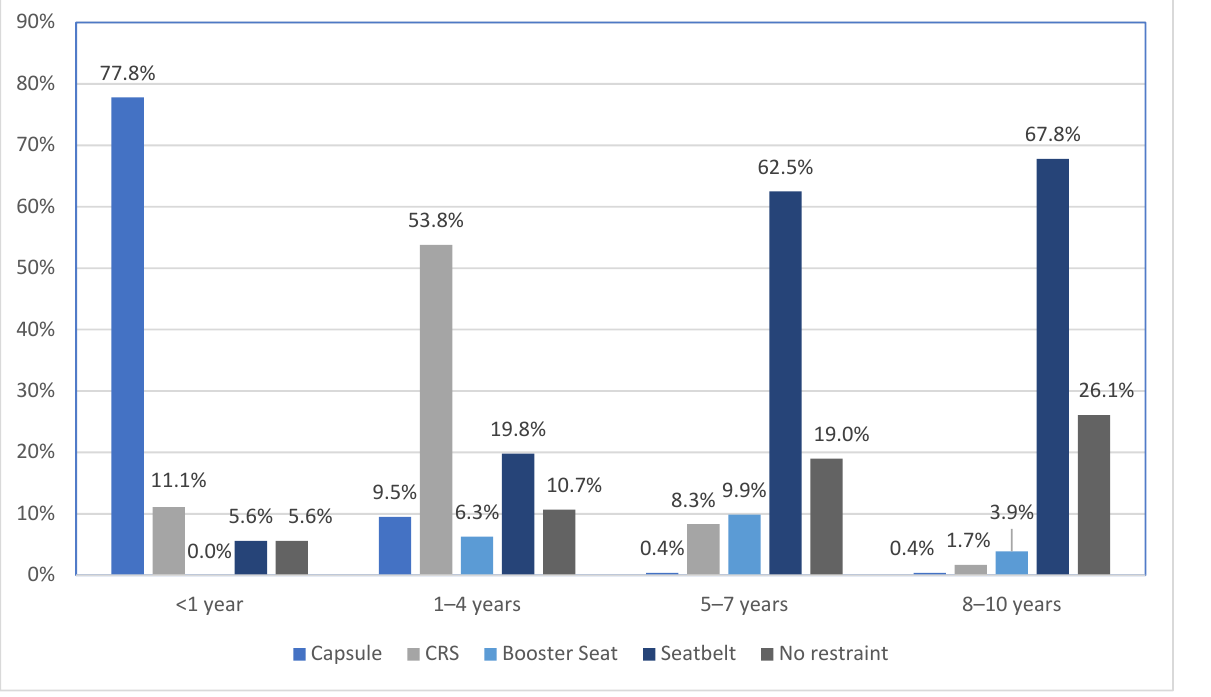
Figure 3. Type of restraint by age group for the eldest child.